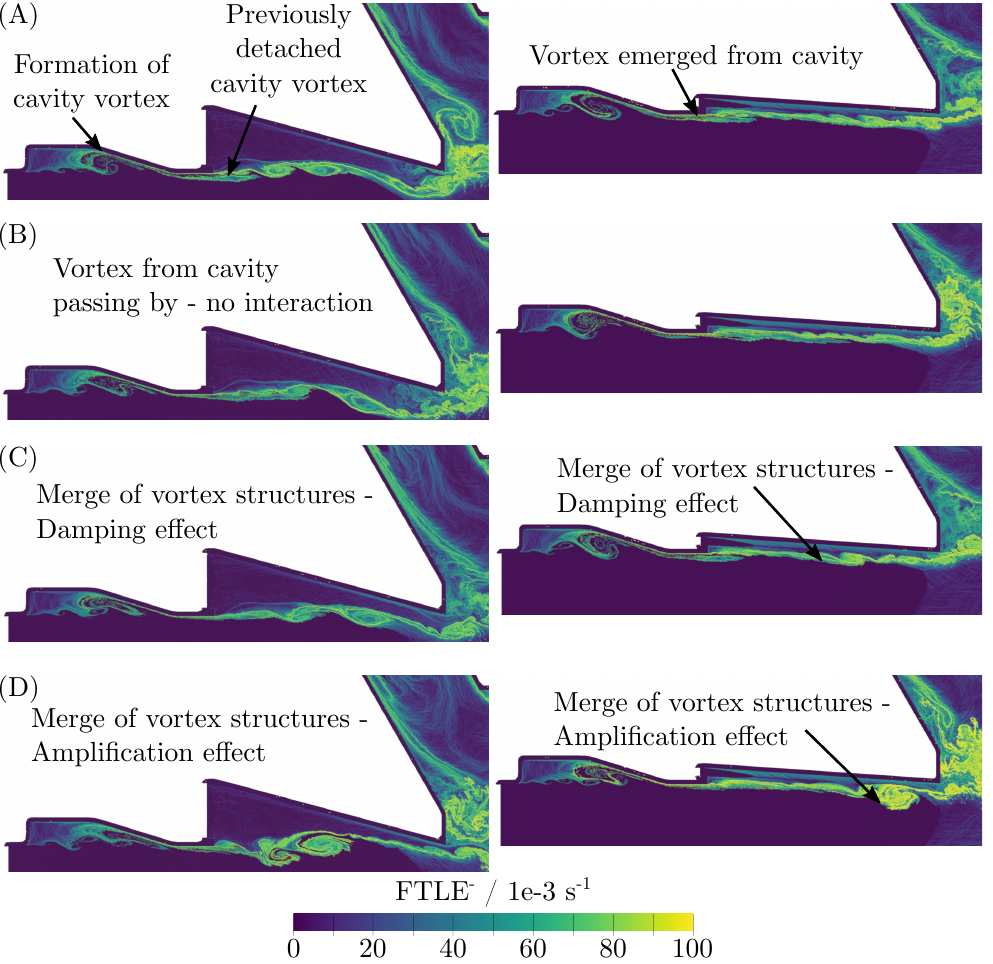
Figure 10. Instantaneous FTLE − fields: ( left ) Wide slit with cavity; ( right ) Narrow slit. ( A ): Vortex detaching from cavity; ( B ): Vortex passing; ( C ): Vortex merging boundary layer at phase interface w/o interaction; ( D ): Vortex merging boundary layer at phase interface with